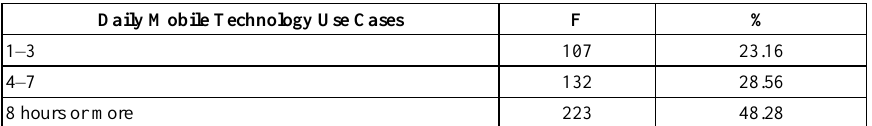
Table 2. Computer usage status of university students